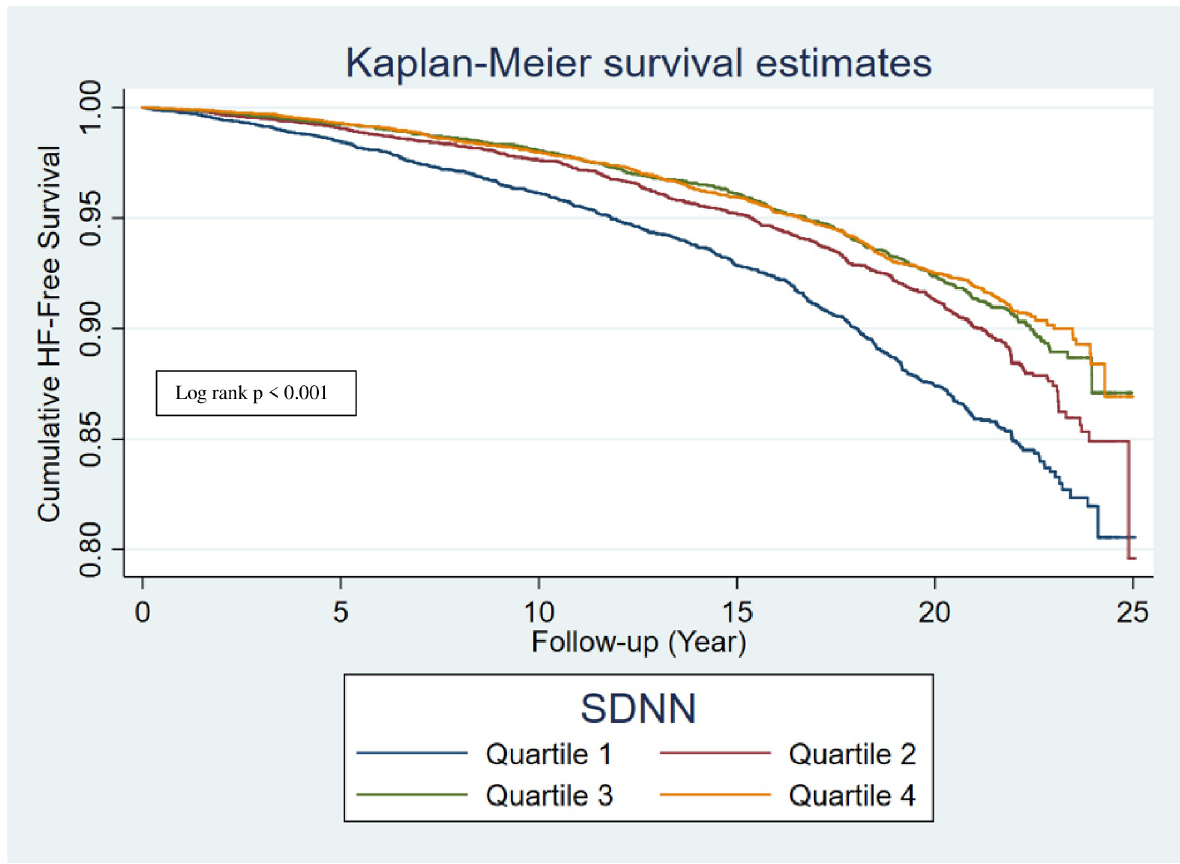
Fig 2. Kaplan-Meier survival curve of incident HF by quartiles of SDNN. HF: heart failure; SDNN: standard deviation of normal-to-normal RR